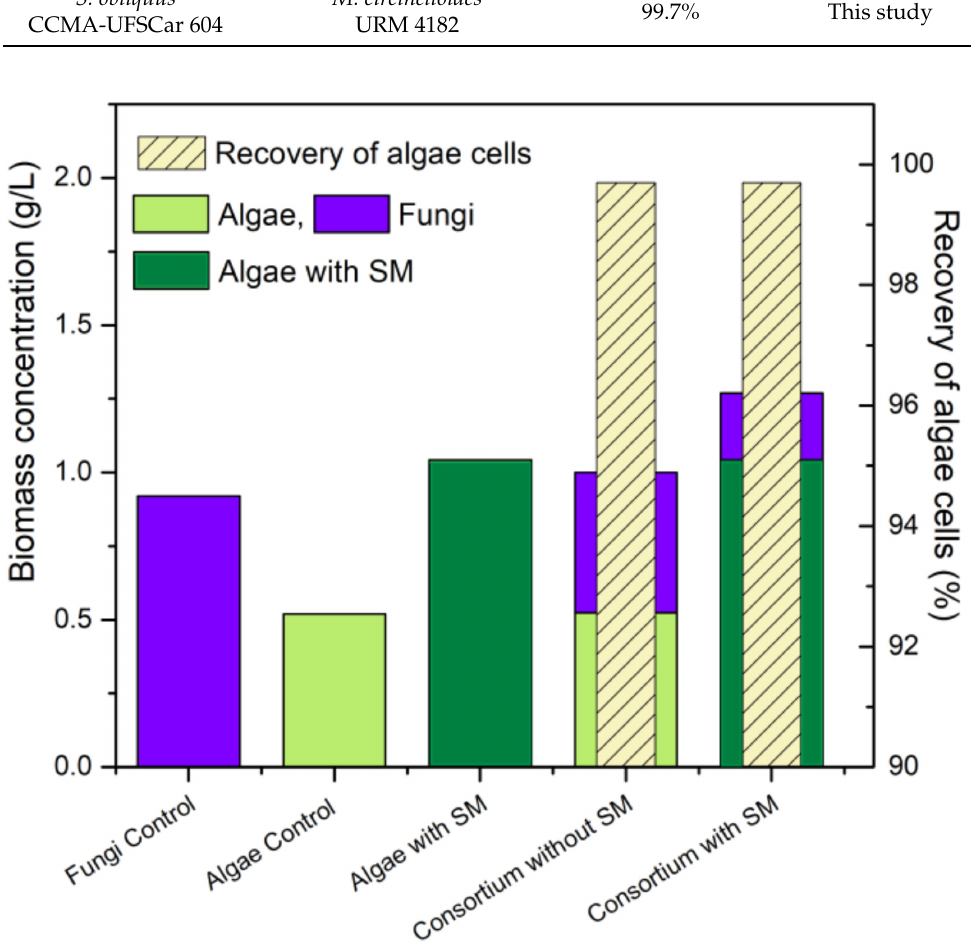
Figure 3. Summary of results according to biomass accumulation and distribution fungi (blue), algae control (light green), algae with SM (dark green) and % recovery of algae cells